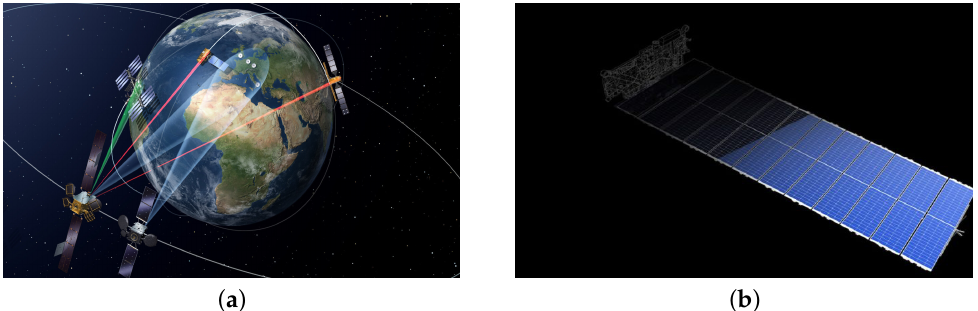
Figure 3. ( a ) European Data Relay System Satellite Constellation. Source: European Space Agency ( b ) One of many Starlink satellites, artist rendition. Source: